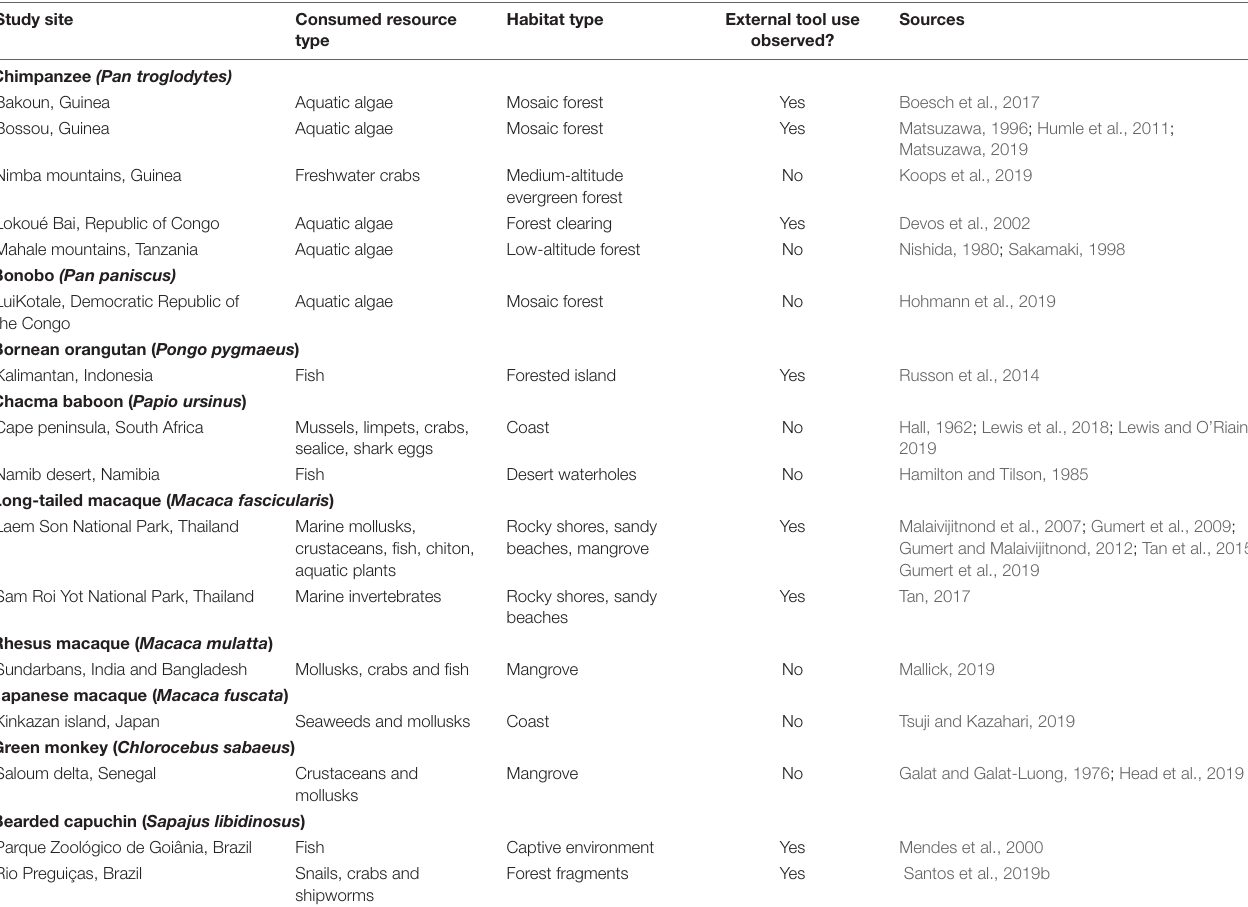
TABLE 1 | Cited examples of aquatic resource consumption by non-human